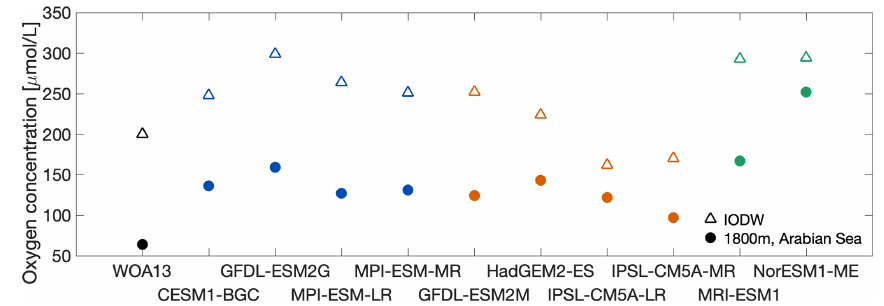
Figure 6. Mean oxygen concentration of IODW at its formation site (triangles) and oxygen concentration at the bottom of the OMZ at 1800m of depth in the AS (circles). The colours mark the oxygen clusters as described in Fig. 5.